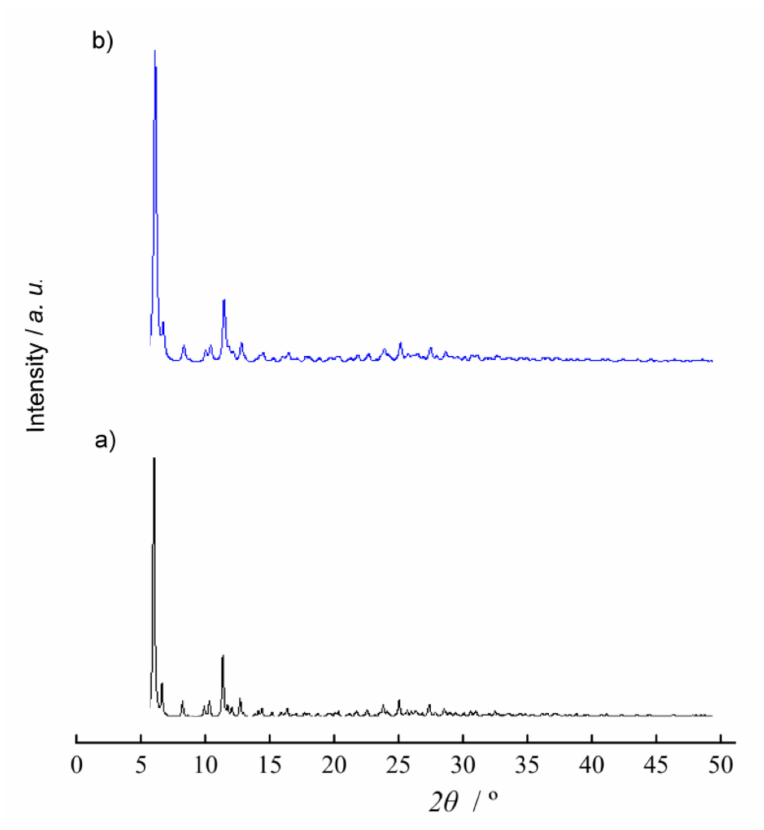
Figure 6. Calculated ( a ) and experimental ( b ) PXRD pattern profiles of CMP MOF 1 measured at room temperature in the 2.0 to 50.0 2 θ